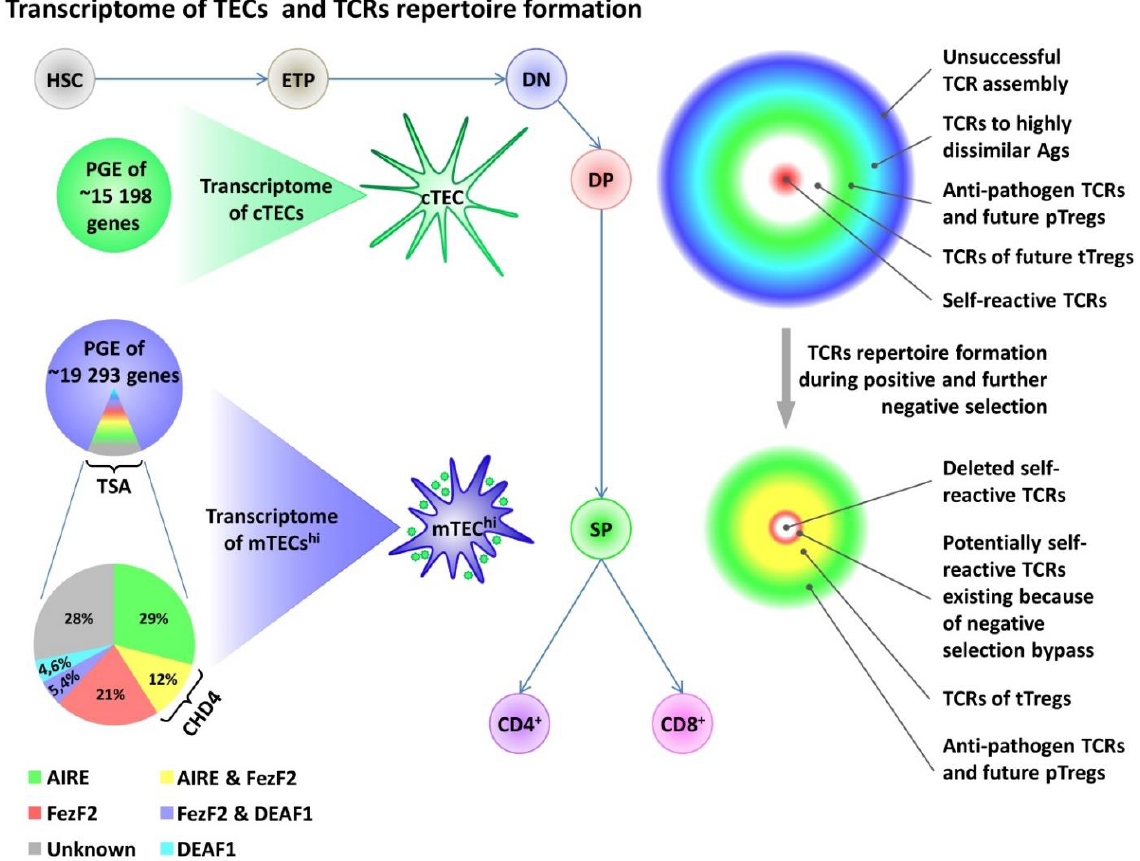
Figure 5. TECs transcriptome and TCRs repertoire formation in the thymus. PGE is common to cortical and medullary TECs. However, mTECs have higher PGE than cTECs due to the expression of several transcriptional factors as AIRE, FezF2, and DEAF1, which also provide transcription of thousands of TSAs genes in mTECs. The contribution of these transcription factors to TSAs expression is shown in the Figure as a percent of total TSAs expression in mTEC hi population. On the left, changes in the TCR repertoire during positive and negative selection are shown. PGE, Promiscuous Gene Expression; cTECs, cortical thymic epithelial cells; mTECs, medullary thymic epithelial cells; AIRE, Autoimmune Regulator; FezF2, Forebrain Embryonic Zinc Finger-Like Protein 2; DEAF1, Deformed Epidermal Autoregulatory Factor 1; HSC, Hematopoietic stem cells; ETP, Early T-cell Precursor; DN, double-negative stage, DP, double-positive stage, SP, single-positive stage of thymocytes maturation.